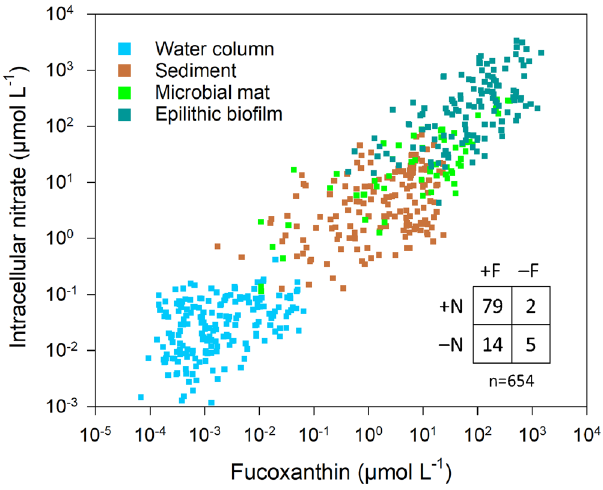
Fig. 2 Global distribution of intracellular nitrate. Overall correlation between intracellular nitrate (ICNO 3 ) and fucoxanthin (a diatom marker pigment) across habitat types and climate zones. Total ICNO 3 and fucoxanthin contents are expressed per unit volume of the respective habitat. The correlation is described by the power function: ICNO 3 ( µ mol L − 1 ) = 3.77 × Fucoxanthin ( µ mol L − 1 ) 0.75 ( R 2 = 0.864, p < 0.001, n = 654). Inset shows frequency distribution (in %) of samples in which intracellular nitrate (N) and fucoxanthin (F) were detected ( + ) or not detected ( – ).